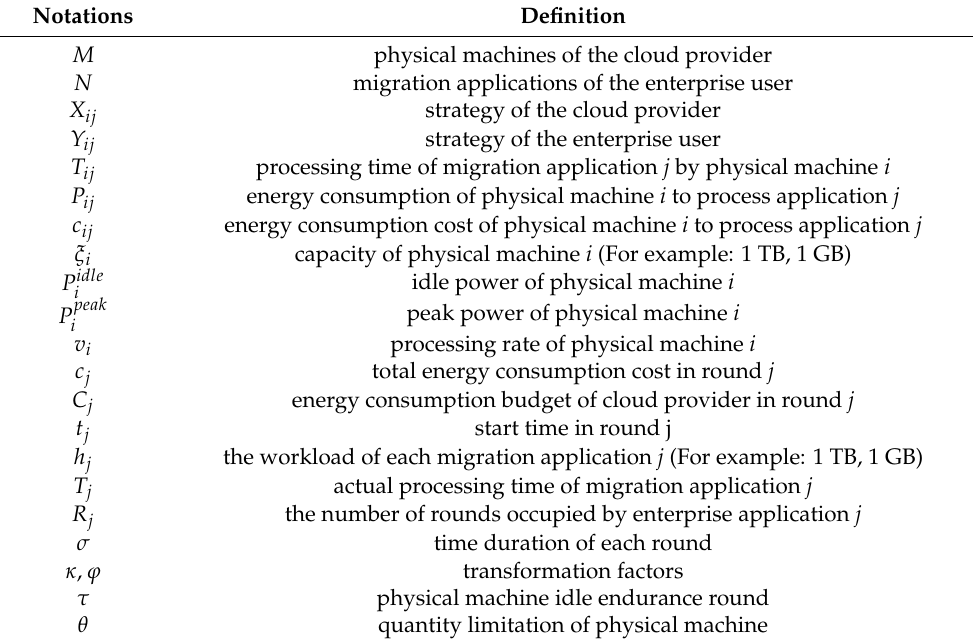
Table 1. Summary of